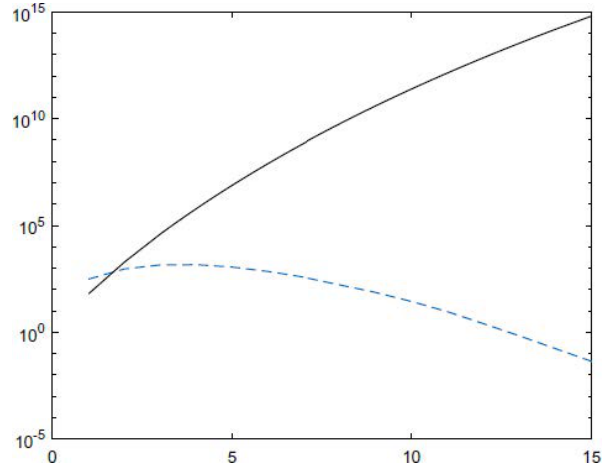
Fig. 2 Maclaurin series expansion coefficient of Tustin transform